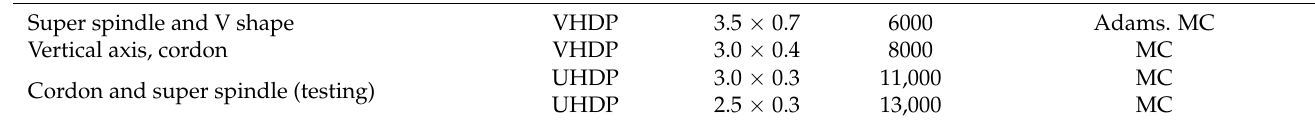
V shape, cordons, vertical and oblique axis